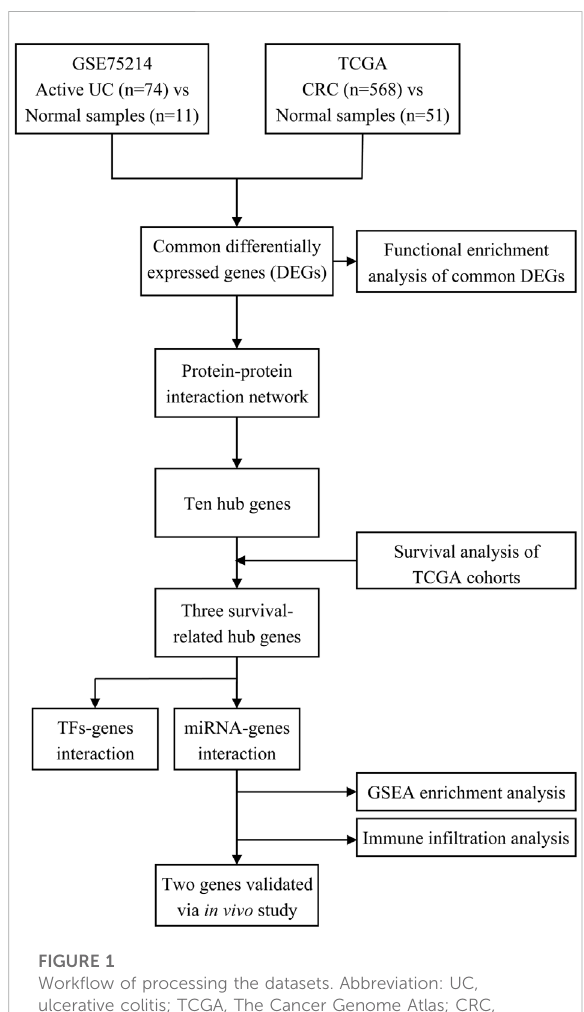
FIGURE 1 Work fl ow of processing the datasets. Abbreviation: UC, ulcerative colitis; TCGA, The Cancer Genome Atlas; CRC, colorectal cancer; TFs, transcription factors; miRNA,